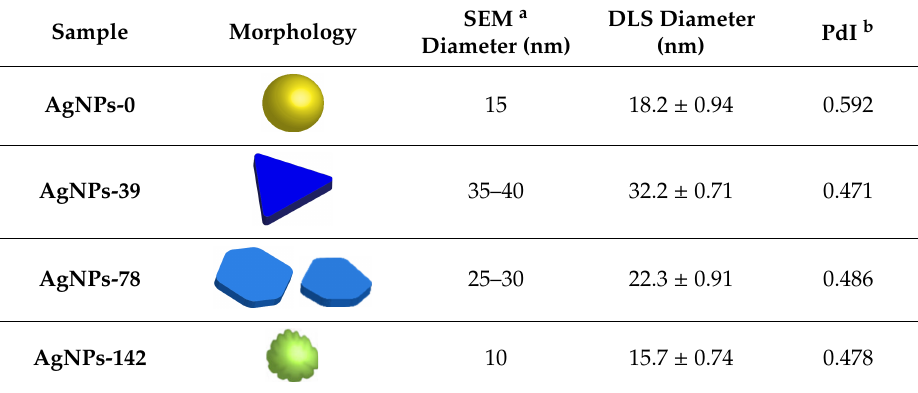
Table 1. Morphology and diameter of synthesized